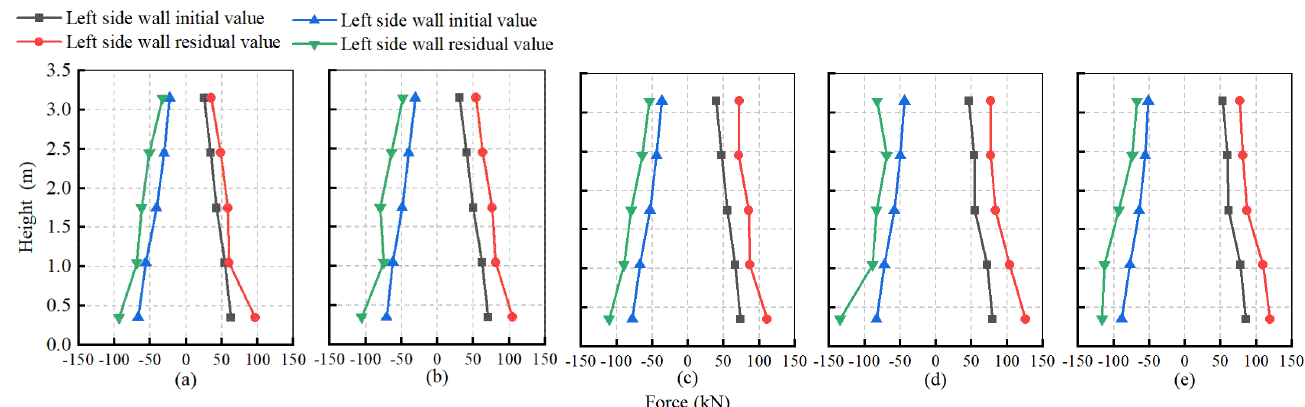
Figure 15. Normal force distribution of the left and right walls at the initial state and the end of the earthquake , the data in ( a ), ( b ), ( c ), ( d ), and ( e ) are from numerical models for 2 m, 2.5 m, 3 m, 3.5 m and 4 m burial depths, respectively.